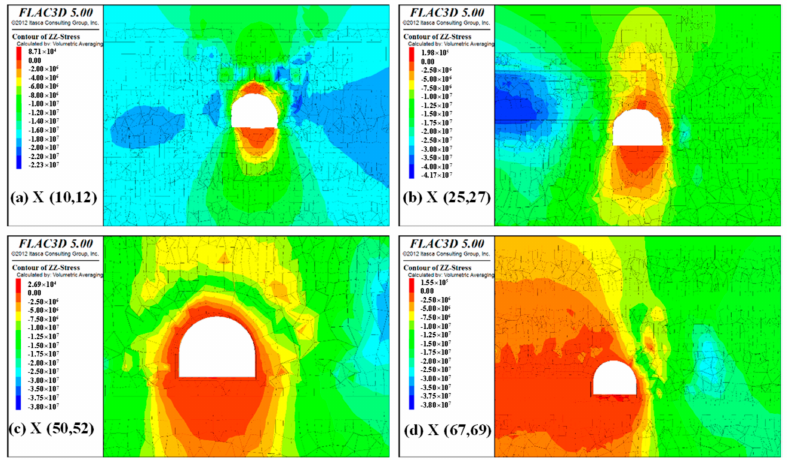
Figure 13. Z − direction stress distribution of the four monitoring areas after excavation of electrome- chanical